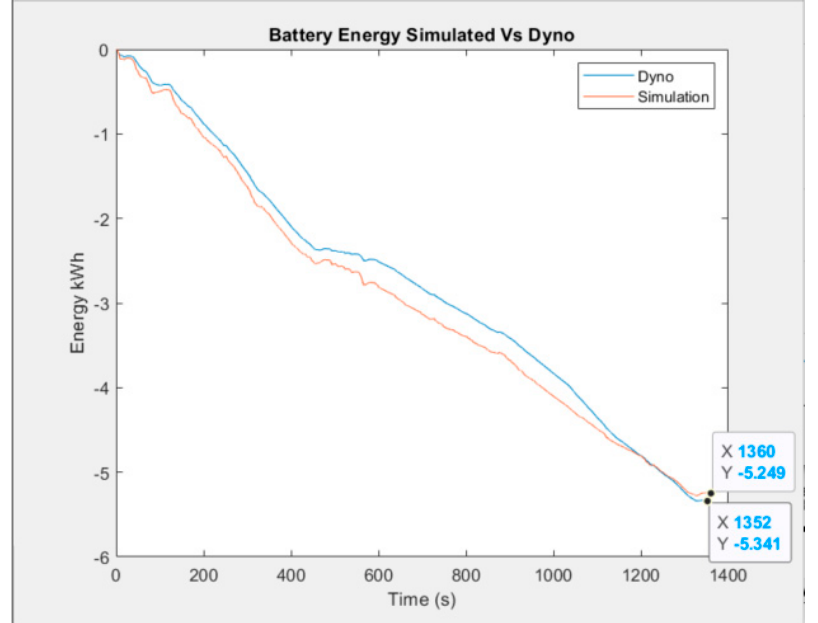
Figure 22. Battery energy over time.